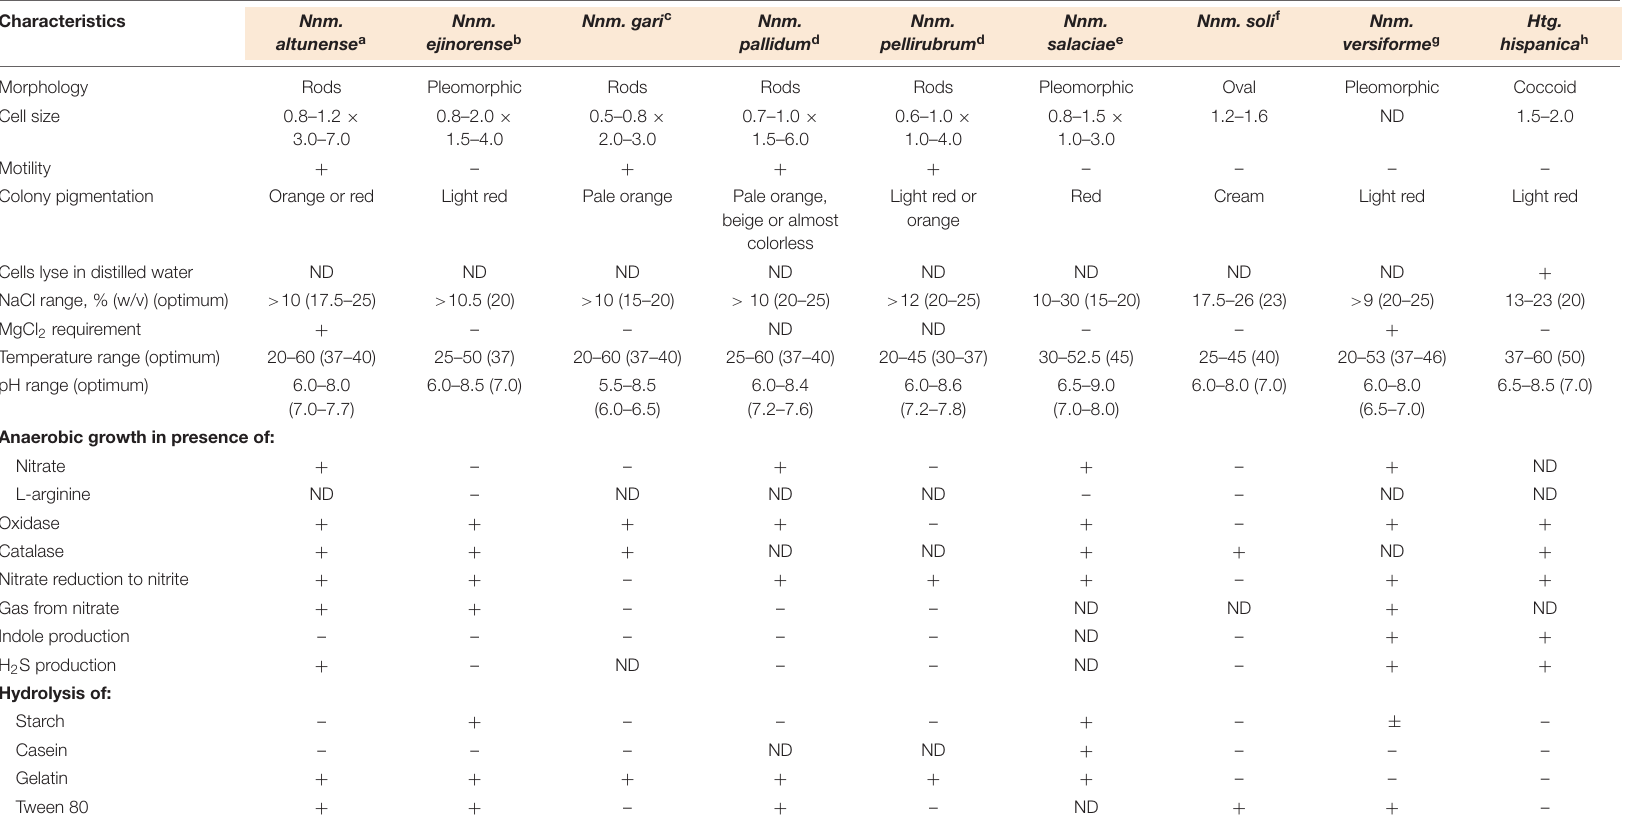
TABLE 2 | Main comparative phenotypic features among members of the genera Natrinema (including the species Halopiger salifodinae ), Haloterrigena, and Natronorubrum .